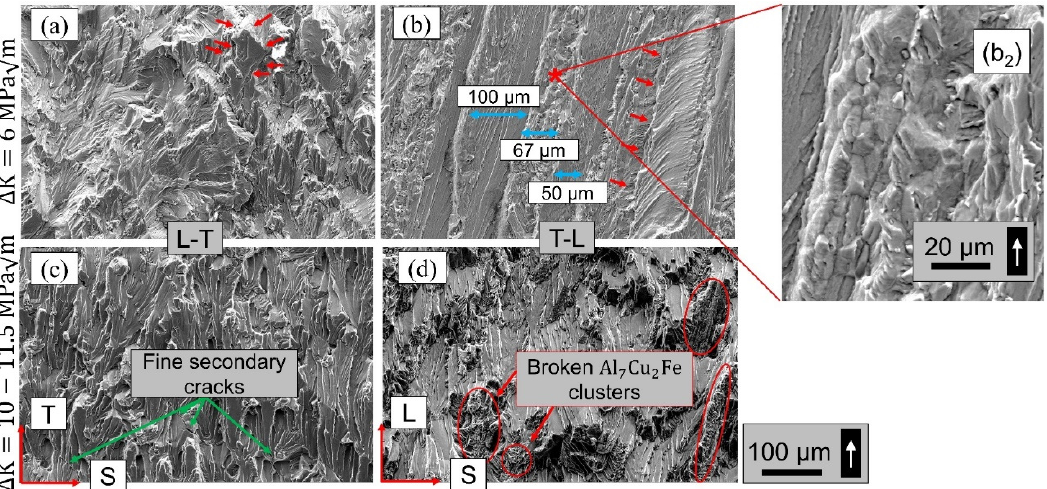
Figure 9. SEM micrographs of fracture surfaces of var 3 ( a ), ( c ) L-T and ( b ), ( d ) T-L samples of low Δ K ( top row ) and higher Δ K ( bottom row ). The white arrow indicates the crack propagation direction ( bottom to top ). ( b 2 ) Inter-(sub-) granular fractured region of ( b ) at higher magnification.